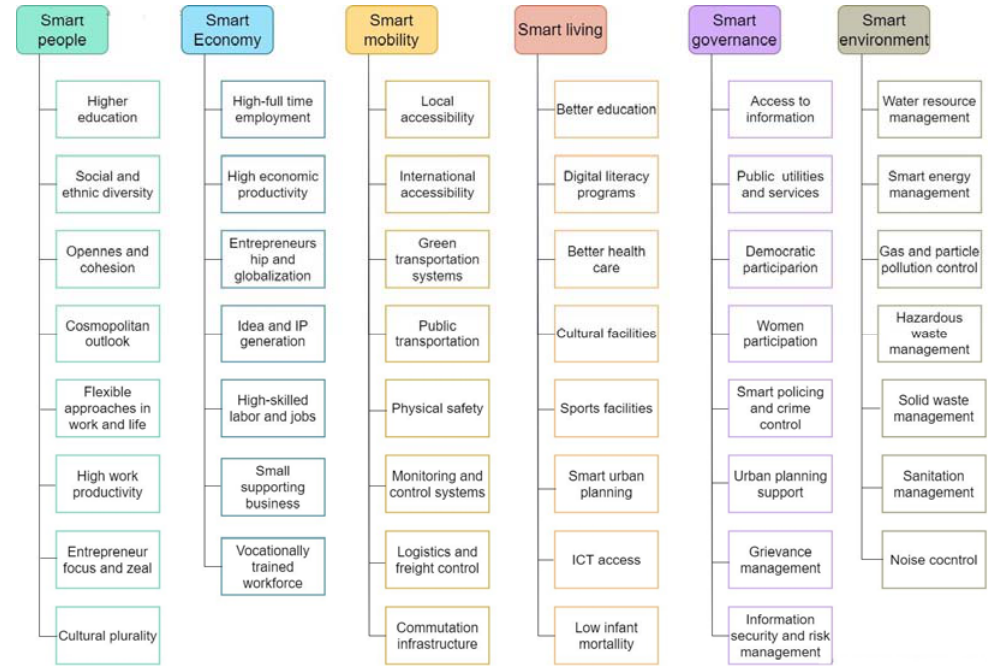
Figure 2. The smart city